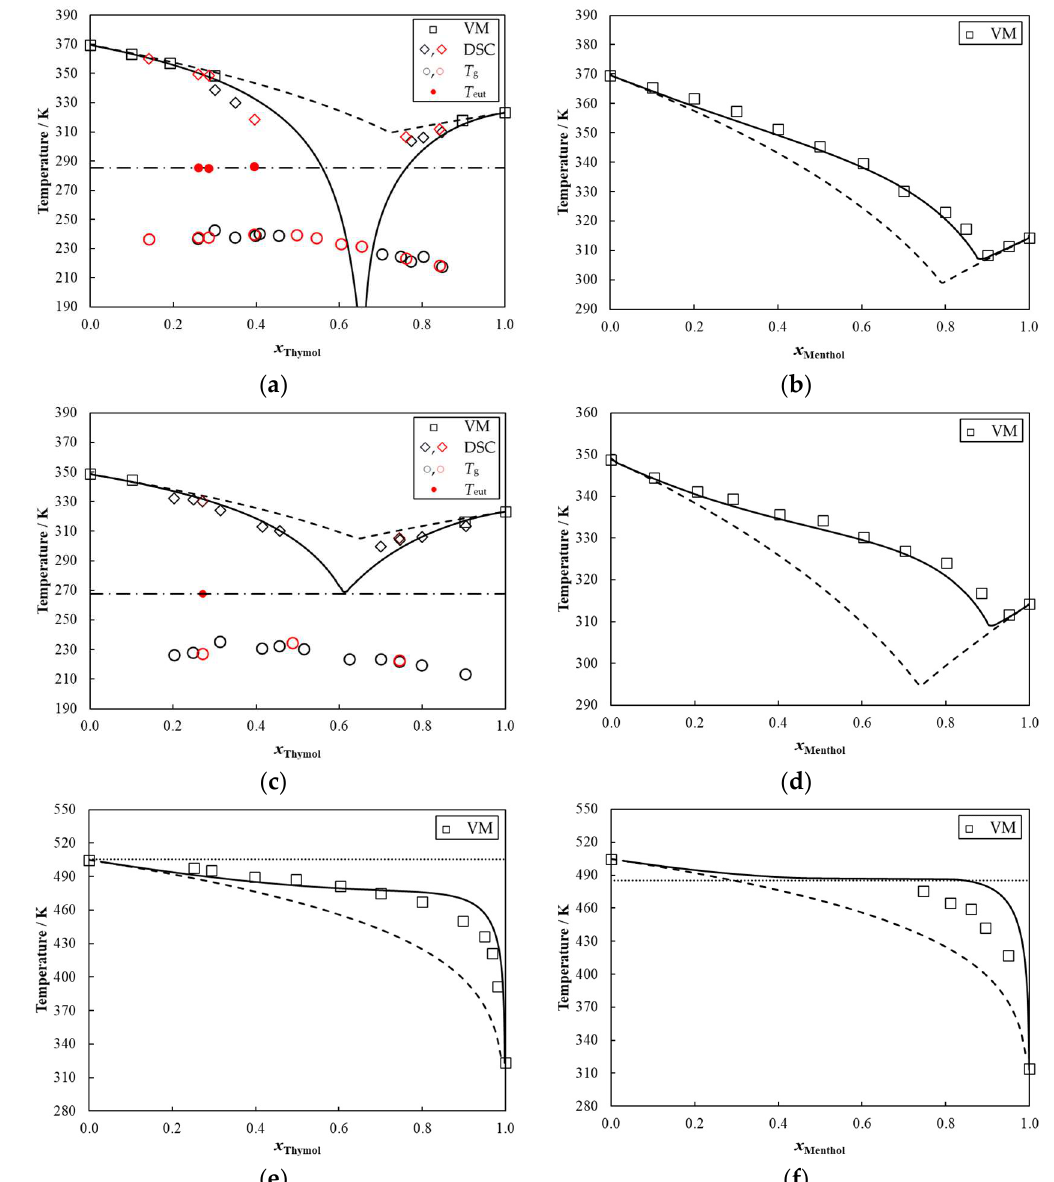
Figure 2. Solid-liquid phase diagrams of ( a ) thymol/flavone, ( b ) menthol/flavone, ( c ) thymol/flavanone, ( d ) menthol/flavanone, ( e ) thymol/hesperetin and ( f ) menthol/hesperetin. Symbols represent experimental melting temperatures, measured using the visual method—VM (□) or DSC ( ◇ ), glass transition temperatures ( T g ) measured using DSC ( ○ ), and eutectic temperatures T eut (•). The DSC measurements and glass transition temperatures in black were obtained with DSC 1 and the red ones, with DSC 2. Lines represent the COSMO-RS predictions (—), ideal melting curves of the system (— —), eutectic temperature line (— • —), and the terpenoid normal